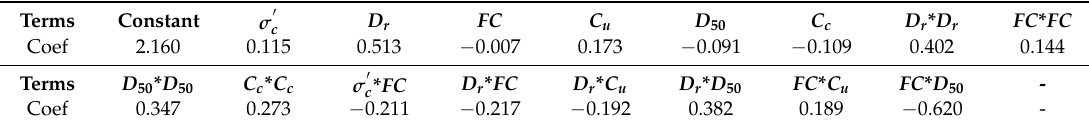
Table 7. RSM equation with the DOE of the HCC design, based on the first ANN model (R 2 = 72.74%, R 2 [adjust] = 60.62%).